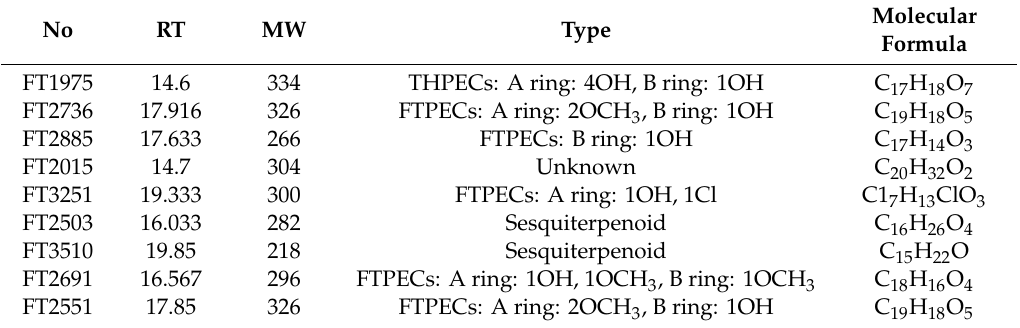
Figure 6. Random forest model based on LC-MS data ( A ) Feature selection based on variables used in PCA. Green, attributes confirmed important; yellow, tentative attributes; red, attributes confirmed unimportant. ( B ) VIP of factors contributing to artificial agarwood grouping in Random Forest model based on attributes selected in A. Table 3. Tentatively identified chemicals contributing to artificial agarwood grouping by LC-MS /